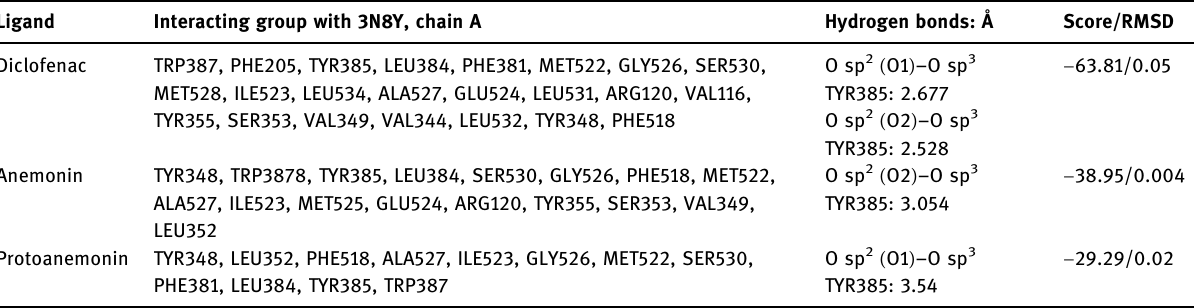
Ligand Interacting group with 3N8Y, chain A